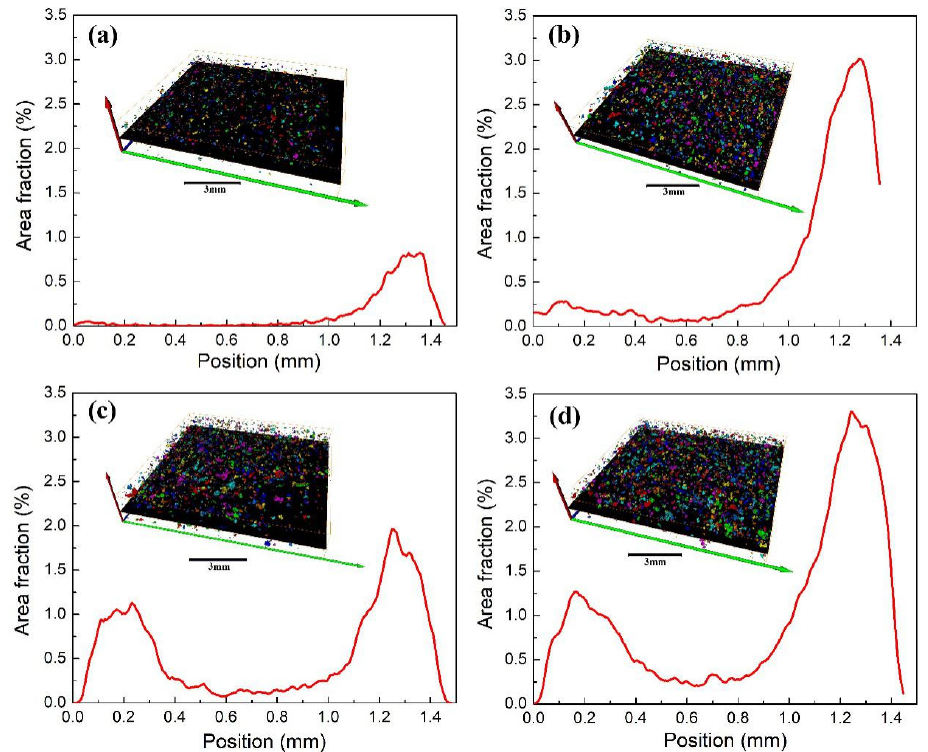
Figure 9. Dependence of the hydrogen blister area fraction along the cross section on the position from the grinded surface (0 mm) to the polished surface (1.45 mm): ( a ) 30 min; ( b ) 180 min; ( c ) 300 min and ( d ) 480 min.